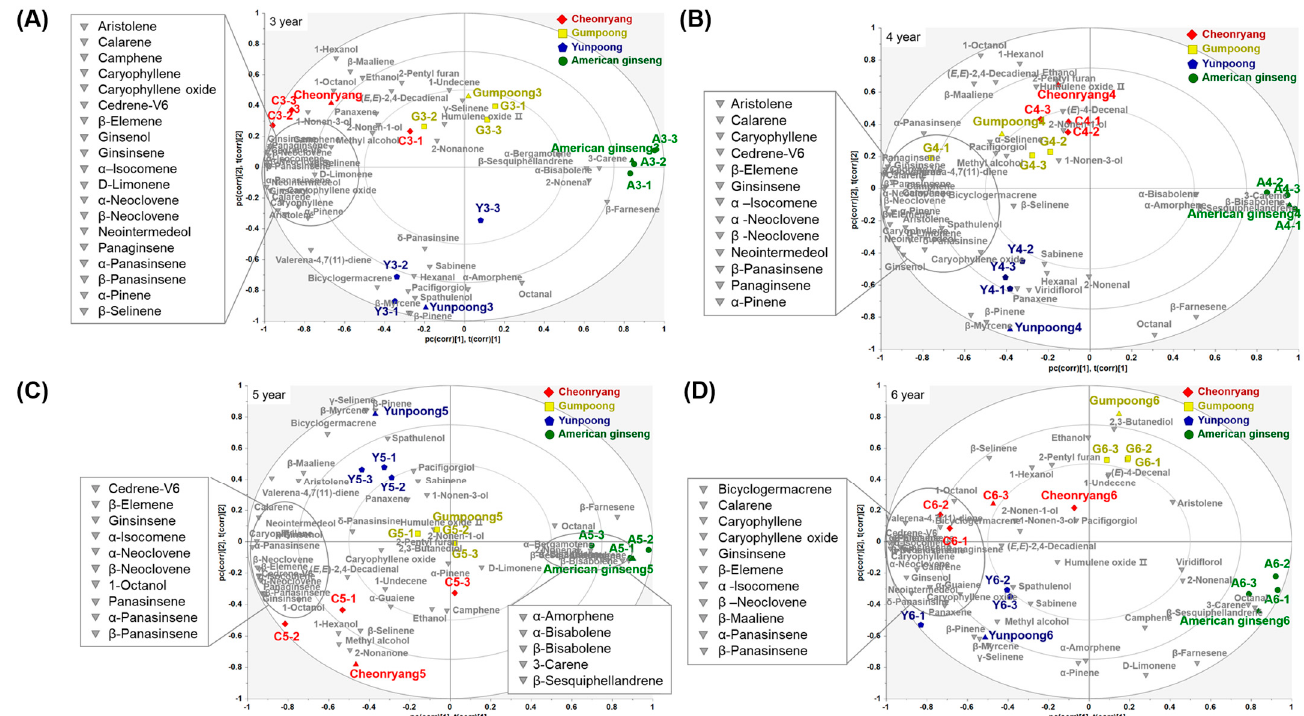
Figure 3. Loading plot of partial least ‐ squares discriminant analysis for four different white ginseng roots based on volatile compound data obtained from GC ‐ MS. ( A ) 3 − year − old, ( B ) 4 − year − old, ( C ) 5 − year − old, and ( D ) 6 − year − old ginseng roots.